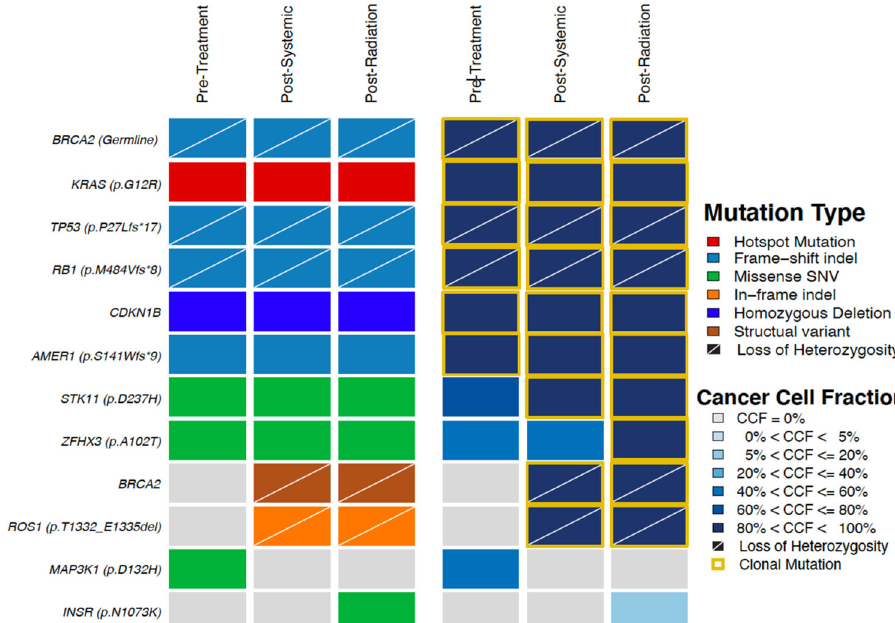
Fig. 4 Heatmap demonstrating identi fi ed genomic alterations in each sample (pre-treatment liver metastasis, post chemotherapy and olaparib CNS metastasis, and post systemic therapy and radiation CNS metastasis, as labeled). The type of alteration is indicated by the color coded heatmap on the left side of the panel and the cancer cell fraction (i.e the proportion of cancer cells harboring an alteration) of each alteration is indicated by the heatmap on the right side of the panel.